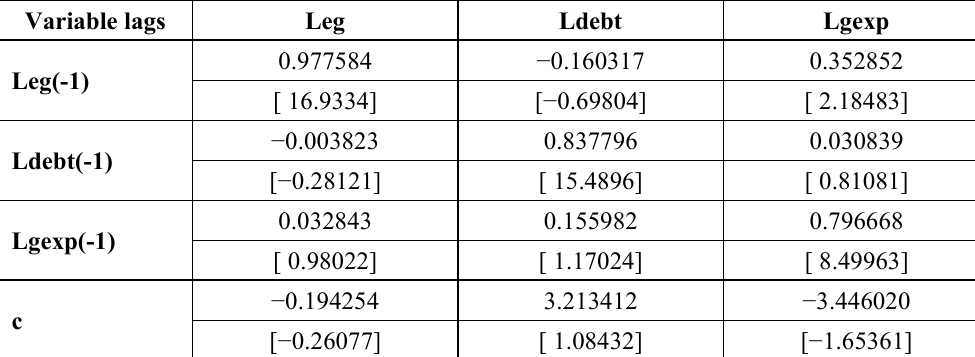
Table 8 . Vector Autoregressive Estimation